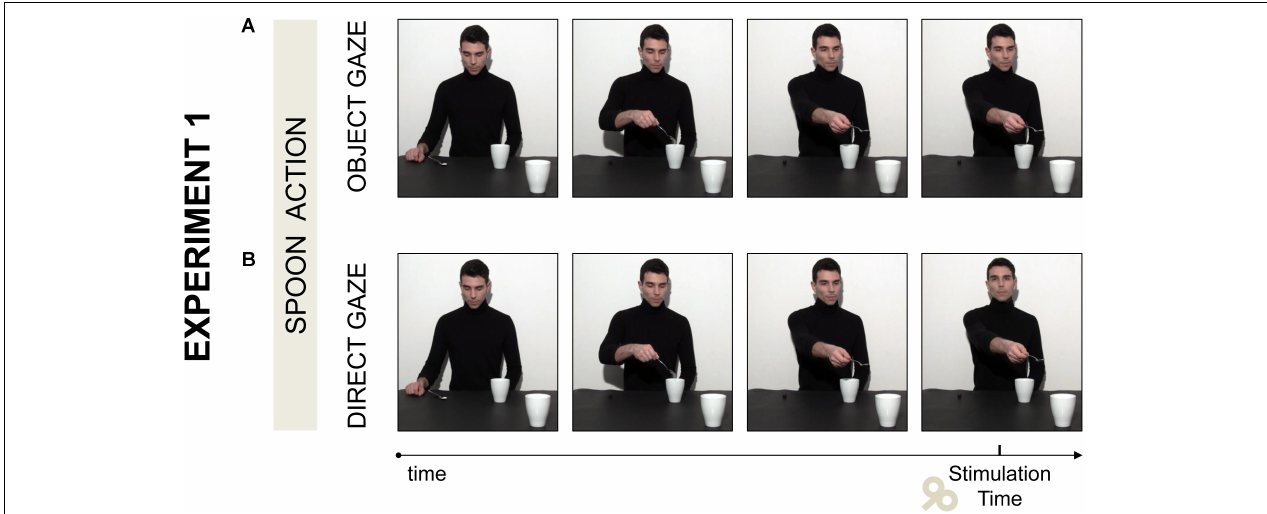
FIGURE 1 | Two video clips were adopted in Experiment 1. (A) In the Object gaze video the actor stretched out his arm toward a mug out of his reach and looked at it. (B) In the Direct Gaze video the actor performed the same action, but at the end of the social request gesture he lifted his head and gazed toward the observer while his arm was stretched out. Single pulse TMS was delivered at the offset of the social request gesture.